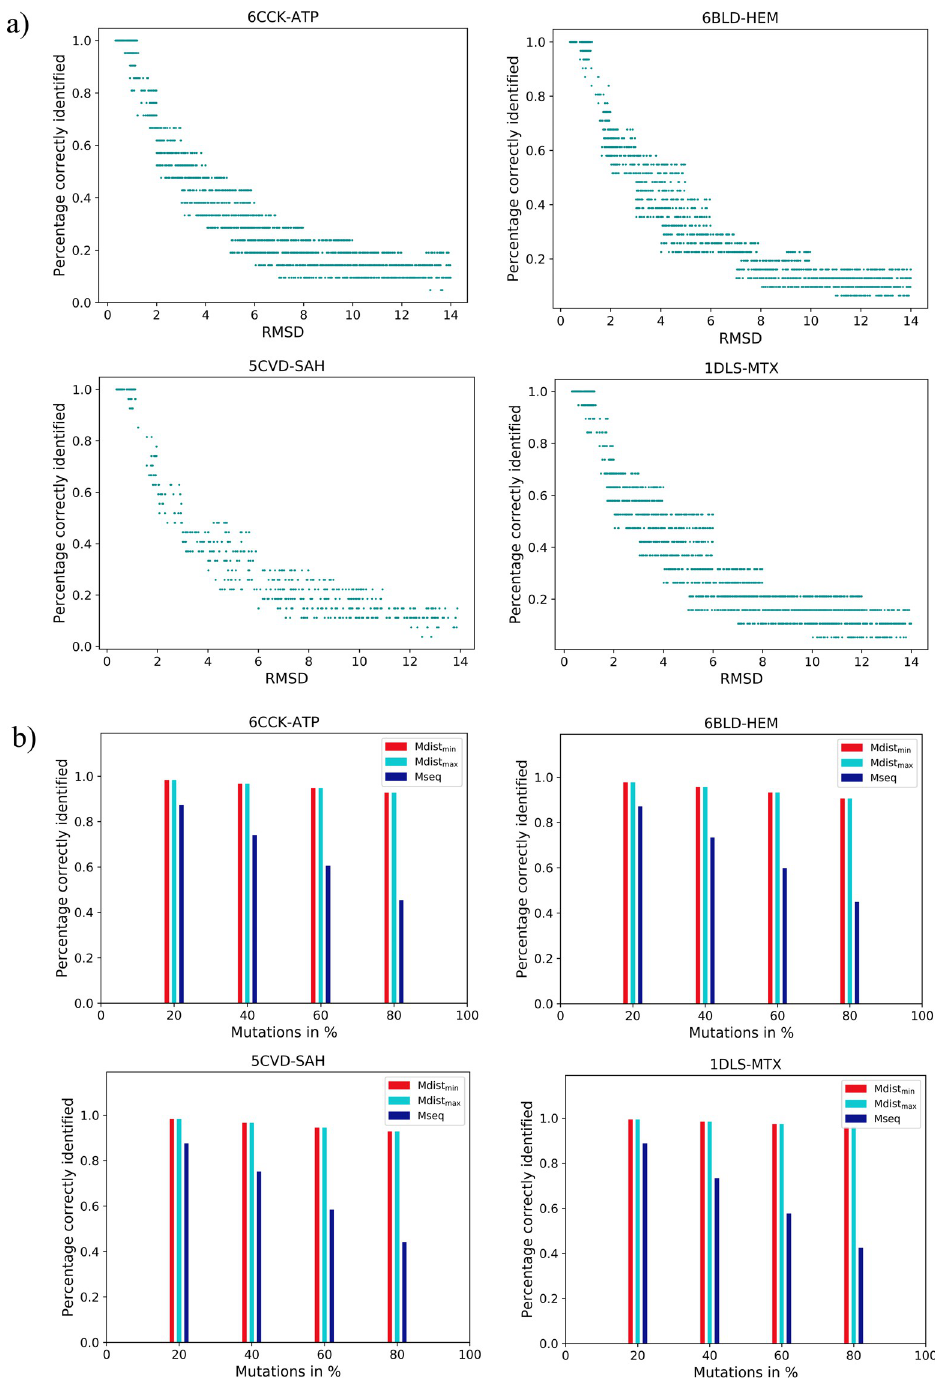
Fig 2. Sensitivity Analysis of SiteMotif: Performance of SiteMotif upon random perturbations (A) in the positions and (B) of residue types, of site residues of the selected examples—PDB-LigID: 6CCK-ATP, 6BLD-HEM, 5CVD-SAM and 1DLS-Methotrexate binding sites. The residue positions in the sites of all ligand binding sites were randomly perturbed in one or more positions such that the RMSD values ranged from 0 to 14 Å . The ability of SiteMotif to correctly identify the alignments was evaluated. In (A) cases where the same residue types but different inter-residue distances as compared to the original site were screened whereas in (B) cases where two sites share similar inter-residue distances but different residue types are tested. In A), a gradual decrease in M-dist min score is seen as the extent of residue perturbation increases. M-dist min scores remain high ( > 0.94) for all cases of perturbation with RMSD < 1.5 Å (B)